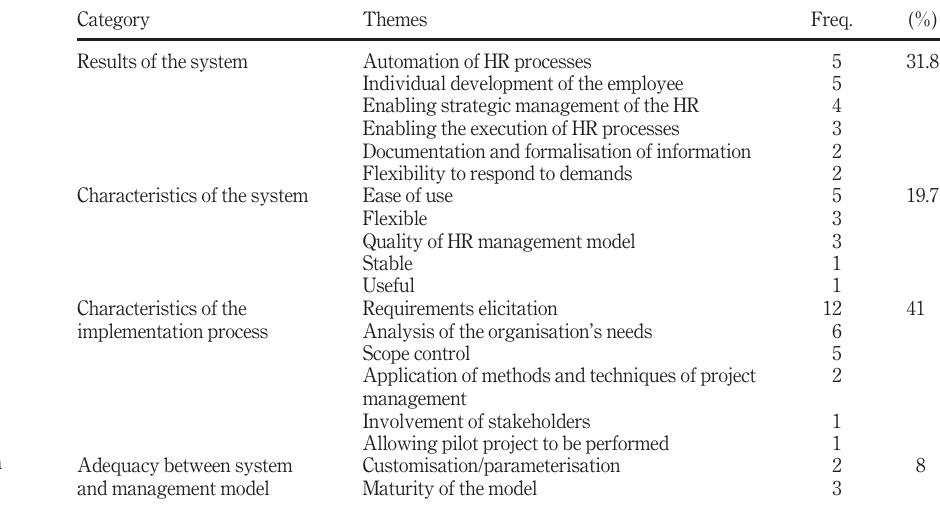
Table III. Results for participants in quadrant